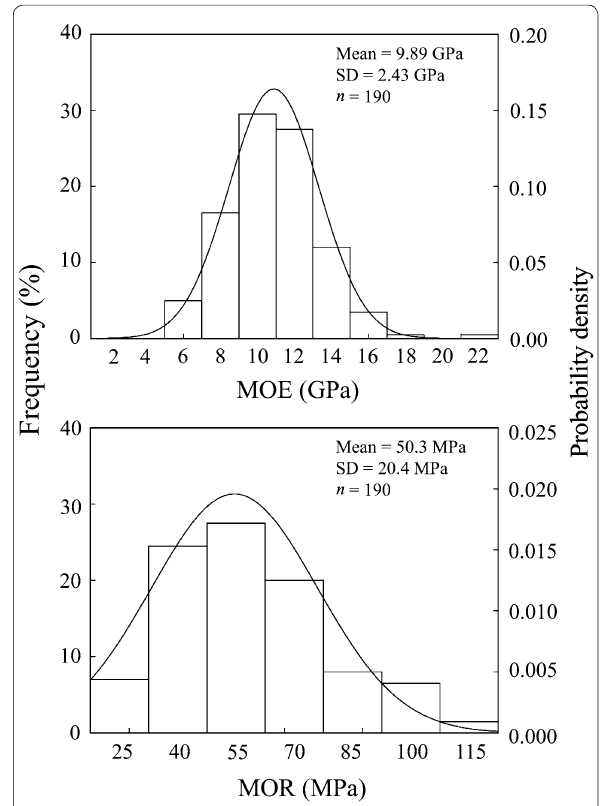
Visual grading The mean values of the air-dry density, MOE, and MOR of the lumber in each visual grade are listed in Table 4. According to visual grading based on the JAS